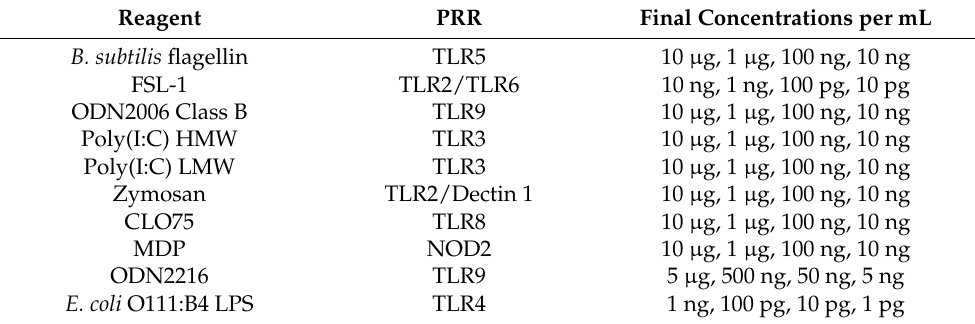
Table 5. Innate Immune Response Modulating Impurities used in the present study. IIRMIs and their final concentrations tested in vitro are summarized. LPS = lipopolysaccharide; CLO = thiazolo- quinolone derivative; MDP = muramyldipeptide; ODN = oligo deoxyribonucleotide; LMW = low molecular weight; HMW = high molecular weight; FSL = Pam2CGDPKHPKSF, a synthetic lipopep- tide derived from Mycoplasma salivarium